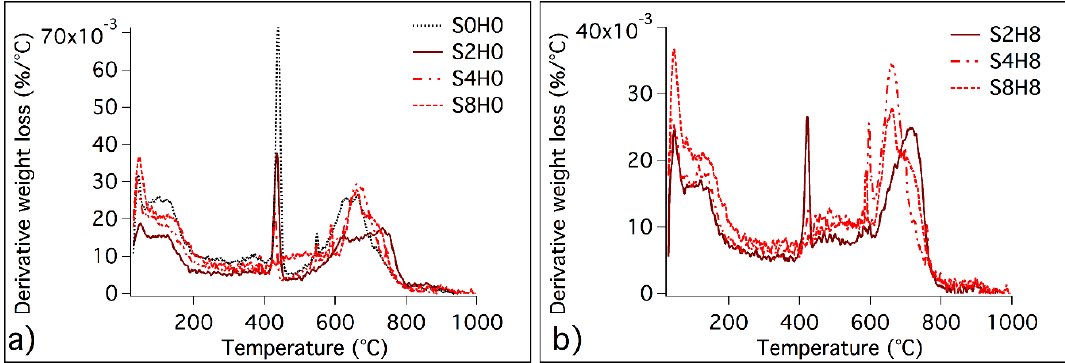
Figure 3. DTG curves of ( a ) S0H0, S2H0, S4H0 and S8H0; ( b ) S2H8, S4H8, S8H8 Samples were lyophilized and analysed after 28 days of hydration.